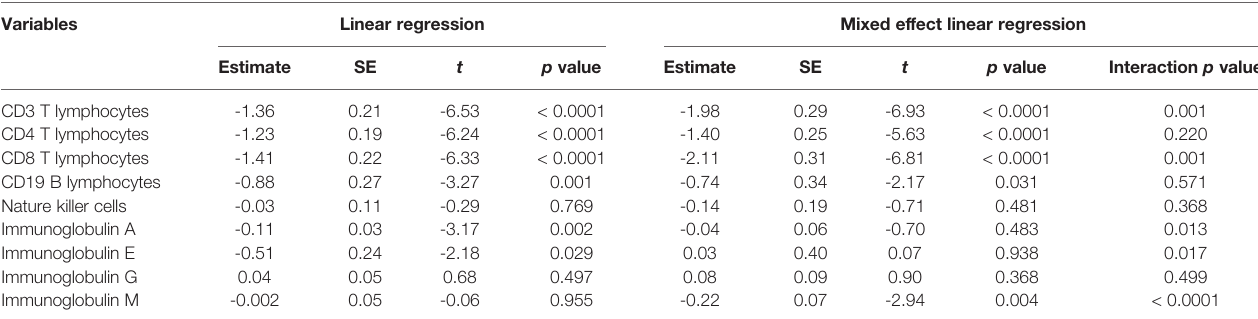
TABLE 3 | Mixed effect linear model of immunological indicators. Variables Linear regression Mixed effect linear regression Estimate SE t p value Estimate SE t p value Interaction p